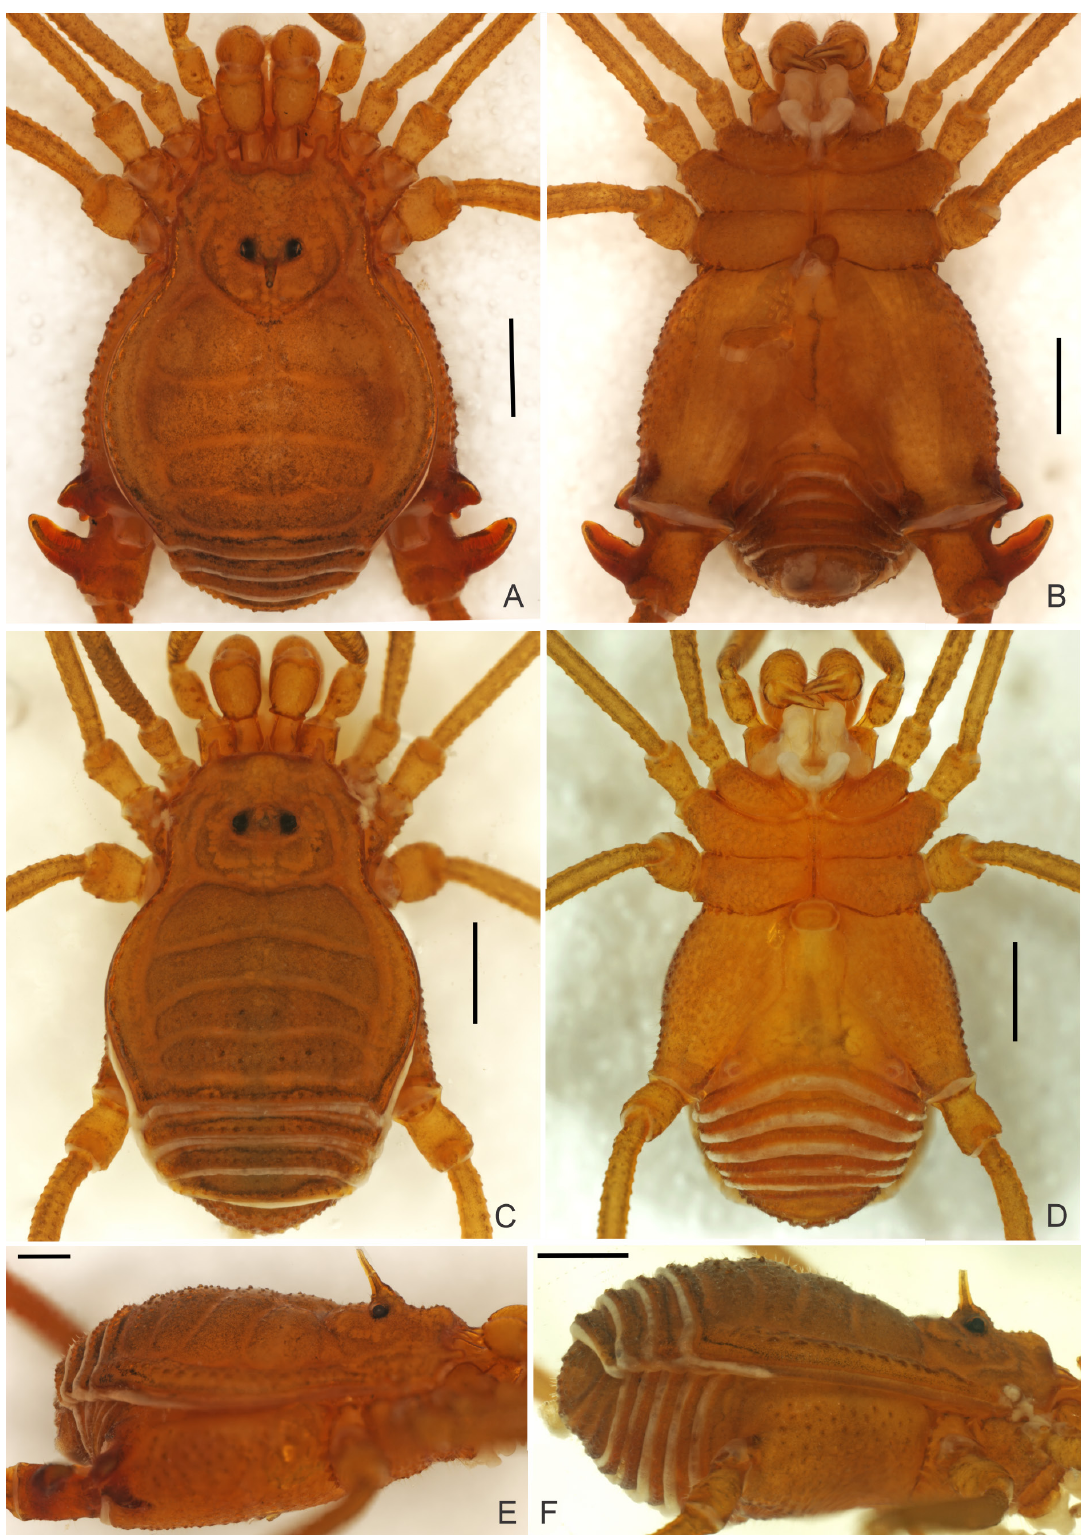
Fig. 4. Eusarcus marmoreus sp. nov., habitus. A – B , E . ♂, holotype (ISLA 12968). C – D , F . ♀, paratype (ISLA 66190). A . Dorsal view. B . Ventral view. C . Dorsal view. D . Ventral view. E–F . Right lateral view. Scale bars: A–E = 1 mm; F = 0.5